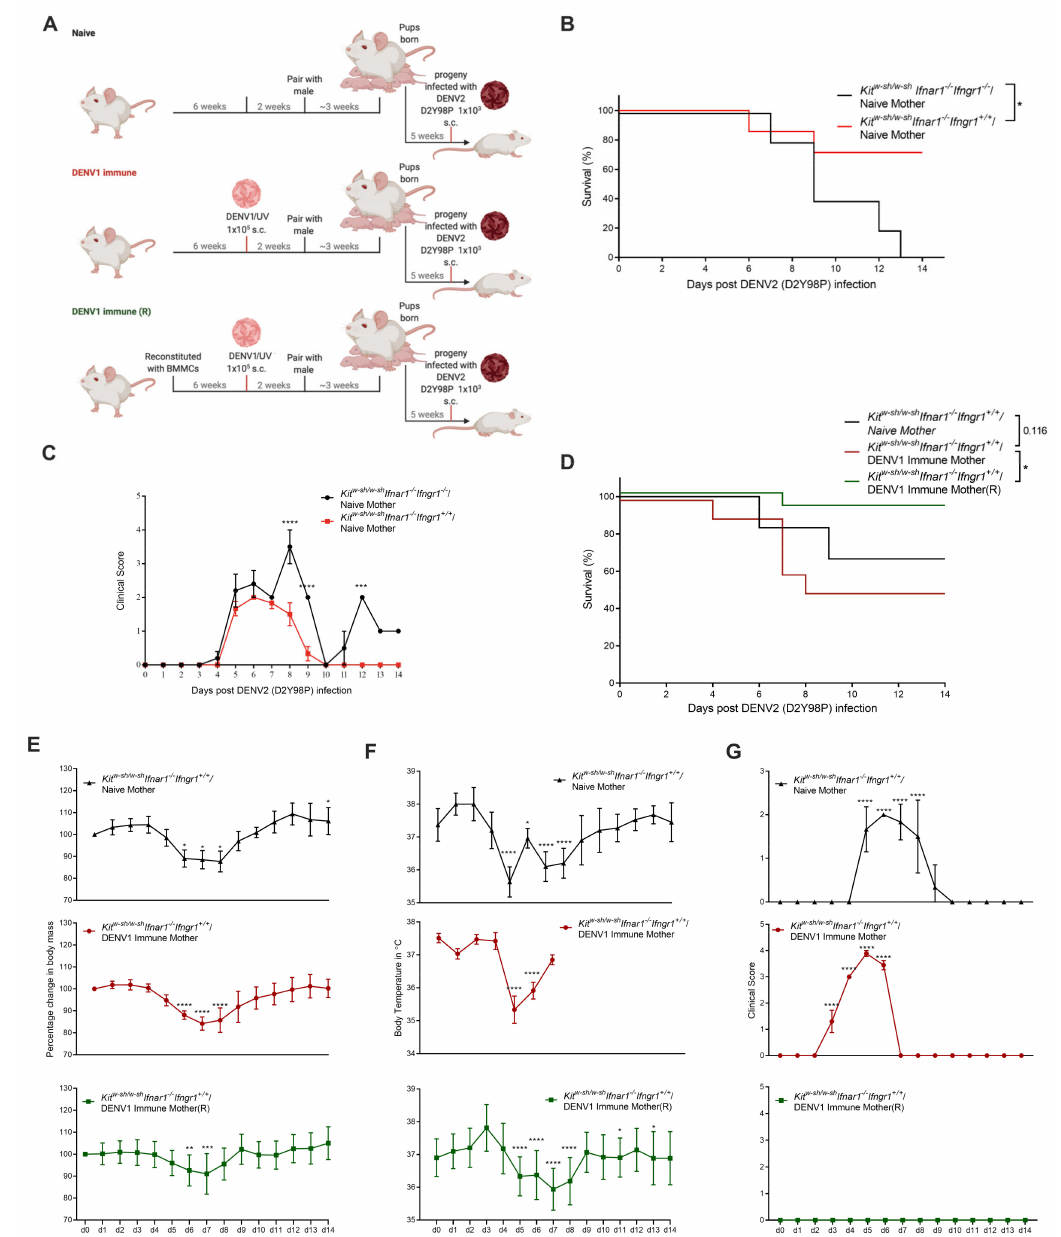
Figure 4. Maternal antibody produced in the presence of MCs provides protection to DENV-infected Kit W-sh/W-sh Ifnar1 − / − Ifngr1 +/+ progeny. ( A ) Experimental timeline depicting maternal vaccination against DENV1 and/or MC-reconstitution for naïve or DENV1-immune mice, followed by mating and exposure of progeny to DENV2. ( B ) Data reproduced from Figure 3B,D in a new graph for statistical comparison of survival of DENV2 infected progeny of DENV-naïve Kit W-sh/W-sh Ifnar1 − / − Ifngr1 − / − versus Kit W-sh/W-sh Ifnar1 − / − Ifngr1 +/+ mice. ( C ) Data reproduced from Figures 3E and 4G in a new graph for statistical comparison of the clinical score of DENV2 infected progeny of DENV-naïve Kit W-sh/W-sh Ifnar1 − / − Ifngr1 − / − versus Kit W-sh/W-sh Ifnar1 − / − Ifngr1 +/+ mice. ( D ) Survival curve of the progeny of naïve and DENV-immune dams with genotypes corresponding to the presence ( Kit W-sh/W-sh(R) Ifnar1 − / − Ifngr1 +/+ ) or absence ( Kit W-sh/W-sh Ifnar1 − / − Ifngr1 +/+ ) of MCs in the mothers ( n = 6–12). Change in ( E ) body weight ( F ) temperature and ( G ) clinical score following DENV2 infection of the mouse groups displayed in panel A. Data represent mean ± SEM, * p < 0.05, ** p < 0.01, *** p < 0.001, and **** p < 0.0001, by one-way ANOVA with Dunnett’s